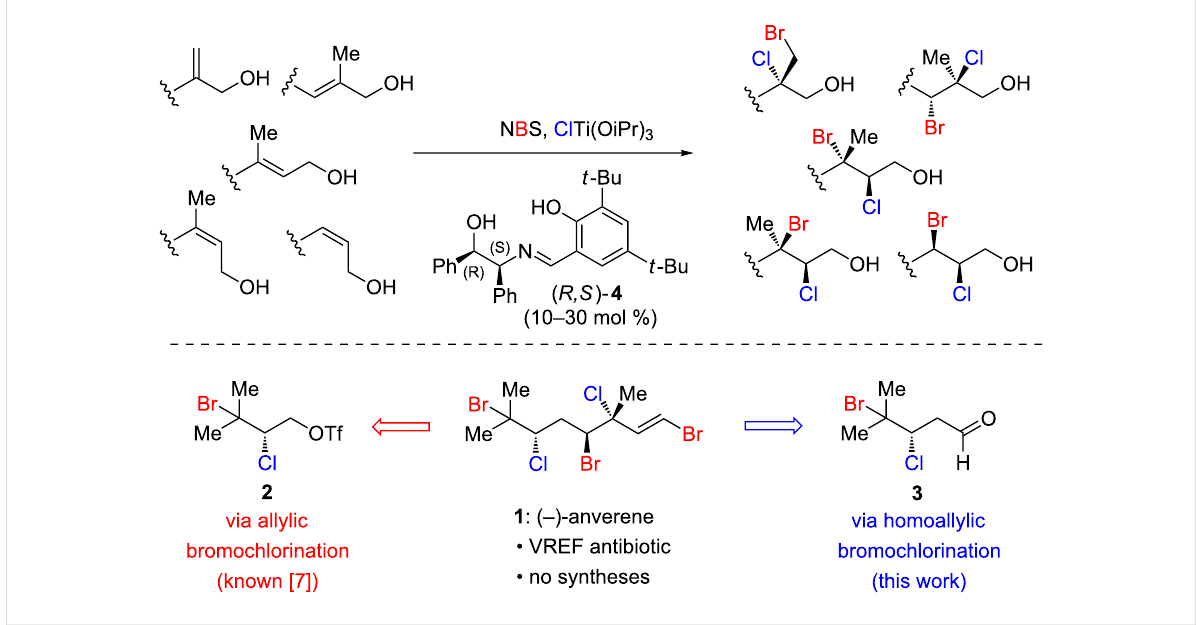
Scheme 1: Selective bromochlorination and possible disconnections for anverene ( 1